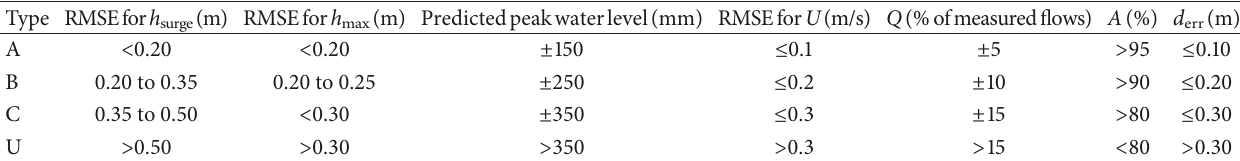
Table 5: Model performance statistics for flood studies in estuaries including storm surge elevation ( h predicted peak water levels, flow velocity ( U ), predicted fluvial inputs ( Q ), flood area predicted correctly for two or more historical floods ( A ), and predicted flood depth error ( d err ) (A � design; B � appraisal; C � strategy; and U � unsatisfactory); from Defra/EA